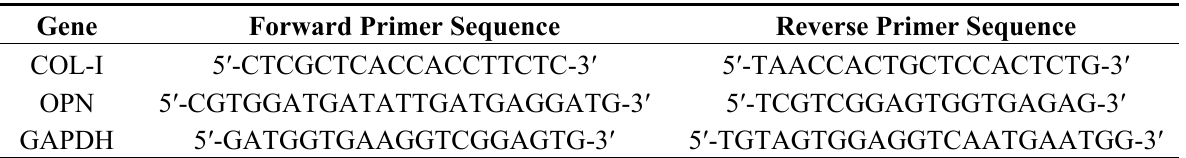
Table 2. Sequences of primers for quantitative reverse transcription-polymerase chain reaction